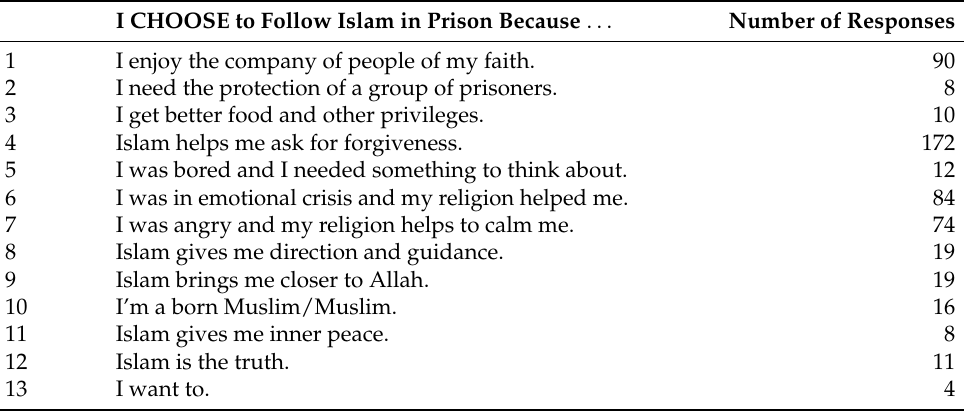
Table 2. UCIP sample’s reasons for choosing to follow Islam in prison. I CHOOSE to Follow Islam in Prison Because . .